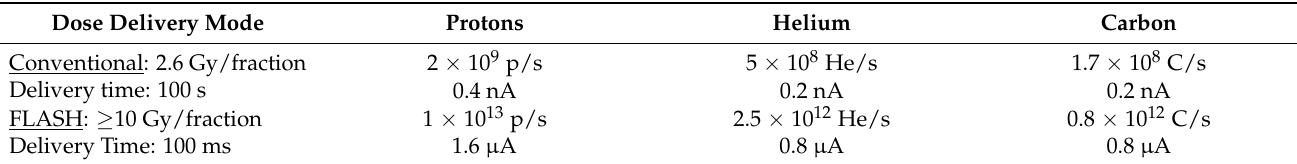
Figure 2. Schematic view of pulsed beam delivery inducing the FLASH effect. (Reproduced from Wilson et al. [12] under the terms of the Creative Commons Attribution License (CC BY), http://creativecommons.org/licenses/by/4.0/) (accessed on 9 September 2022). Table 2. Dose delivery requirements for FLASH for protons and ions extrapolated from electron FLASH